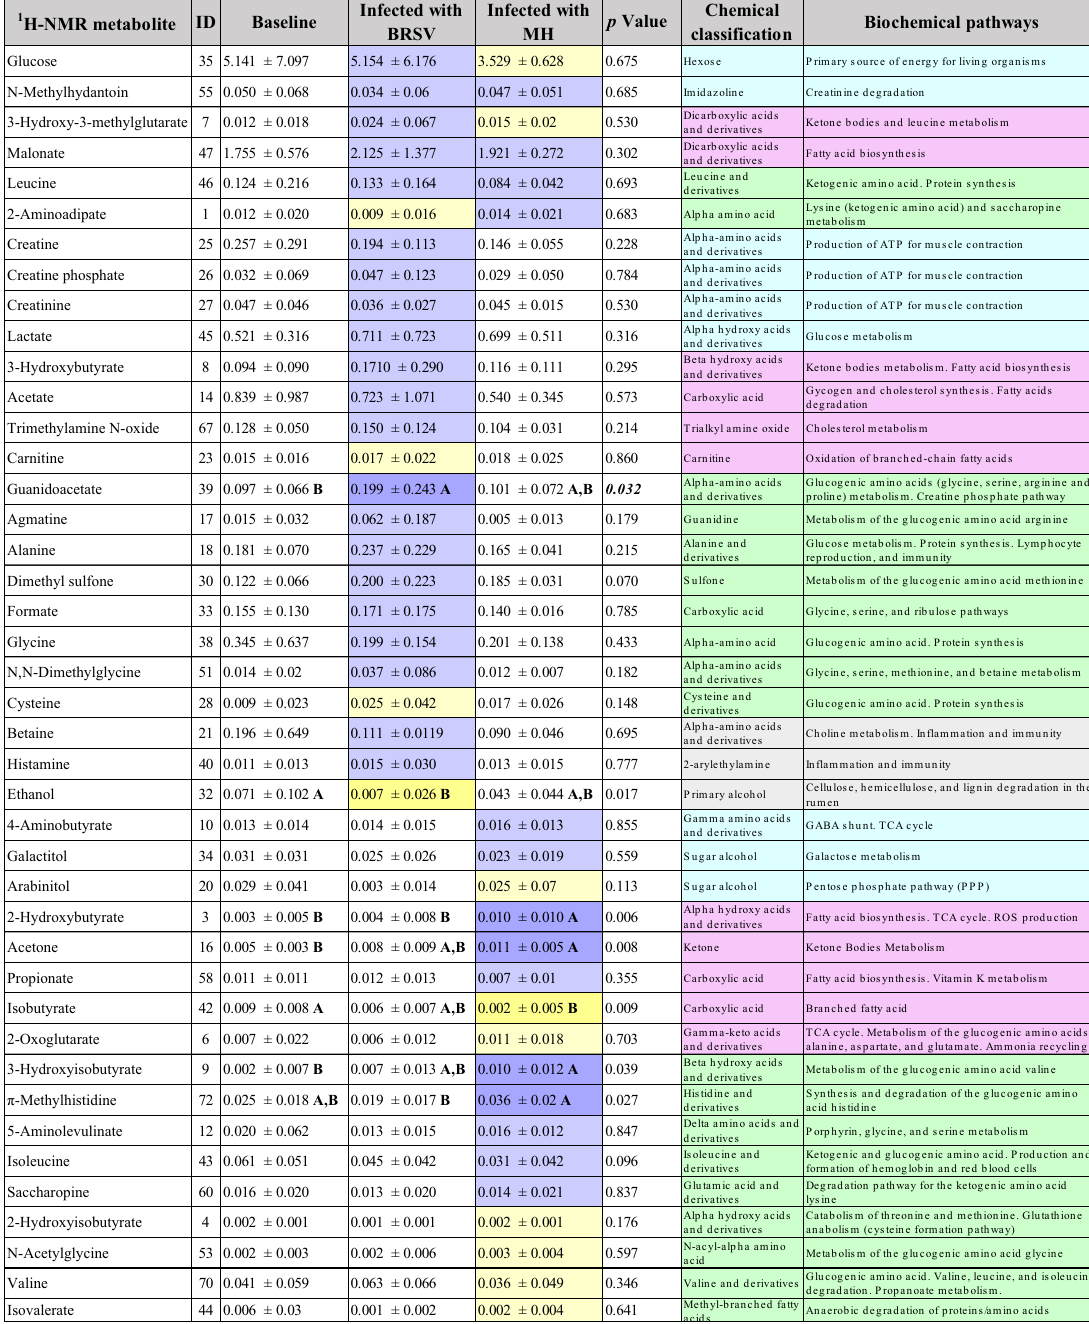
Table 4. Metabolite concentration changes for plasma from dairy calves challenged with BRSV and M. haemolytica . Values are presented as mean ± SD. Categories not connected by the same letter between Baseline, BRSV, and MH were significantly different ( p < 0.05); increase (dark purple), decrease (dark yellow). Values positively (light purple) or negatively correlated (light yellow) in the PCA during infection compared with the Baseline. Biochemical pathways: Grey = other; light blue = glycolysis/gluconeogenesis pathways, magenta = triglycerides pathways, light green = protein pathways. Italic = parameter changed in the ANOVA and the